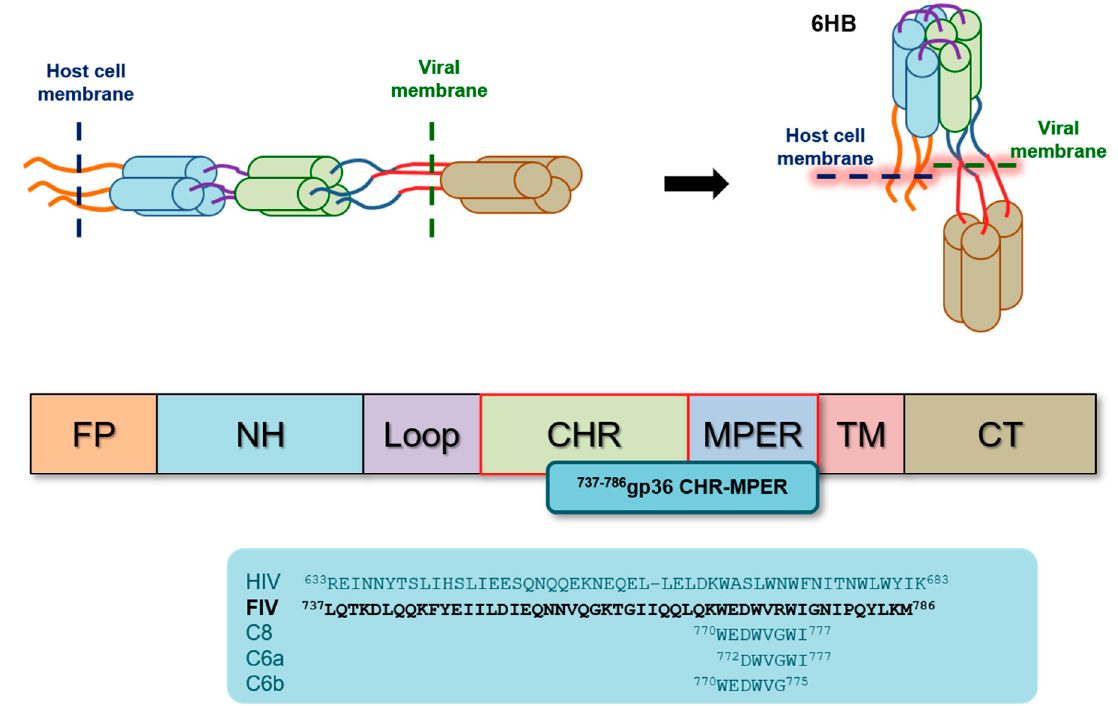
Figure 1. The structural framework and conformational rearrangement of gp41 and gp36 from a pre-hairpin state to the six-helical bundle (6HB). Amino acid sequences of HIV gp41 C-terminal heptad repeat–Trp-rich membrane-proximal external region (CHR–MPER), feline immundeficiency virus (FIV) 737-786 gp36 CHR–MPER, and FIV-derived peptides .